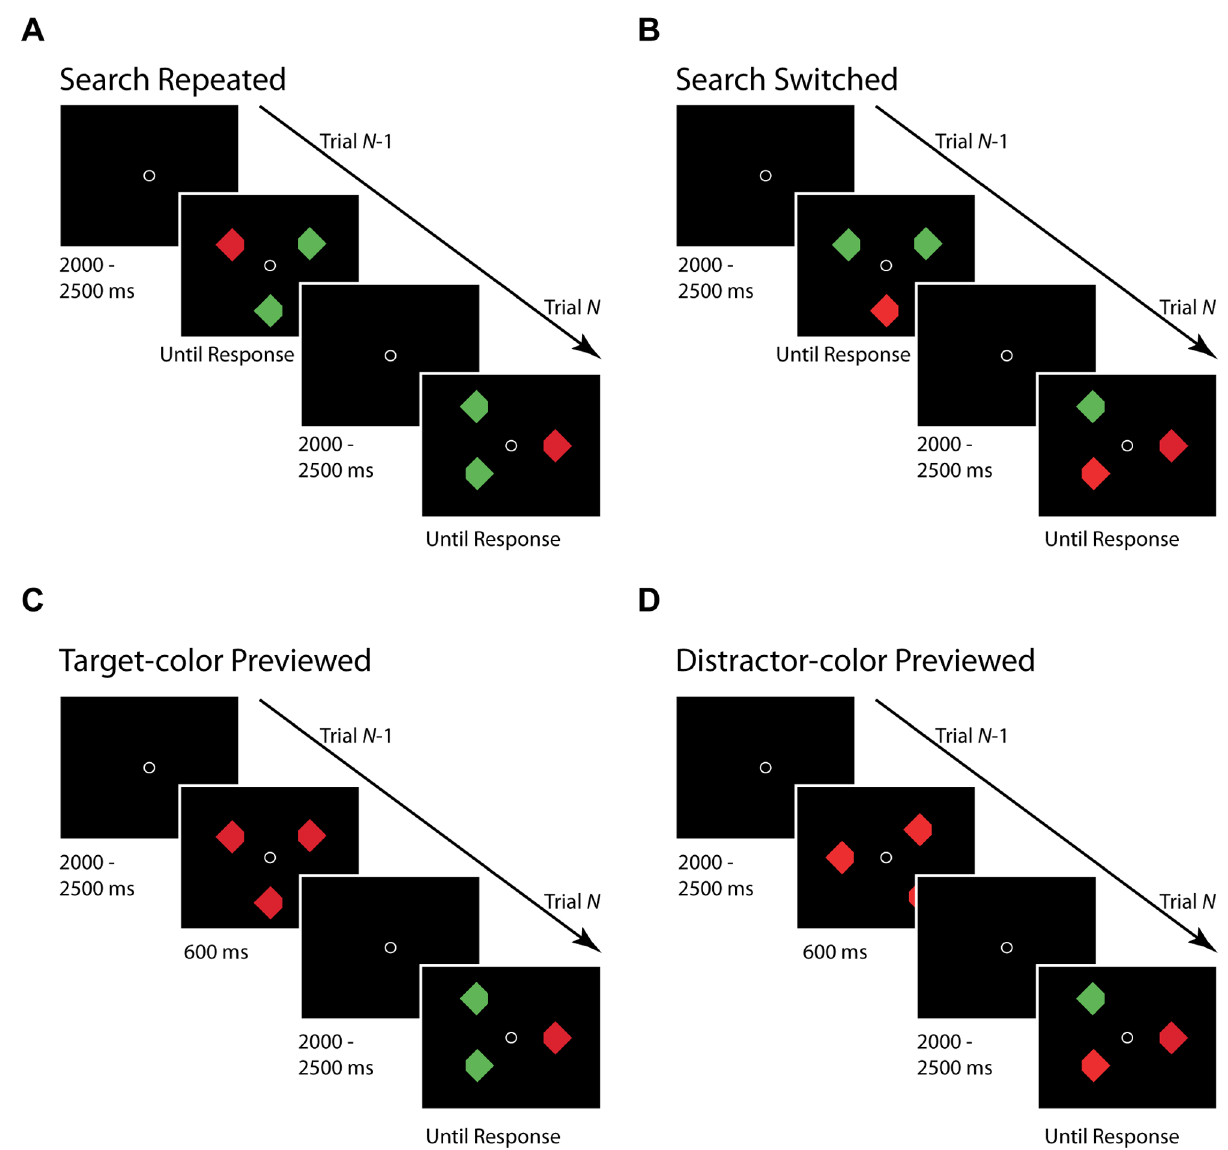
Figure 1. Samples of Four Search Conditions (Target Is Red and Two Distractors Are Green in Current Trial). (a) Search Repeated (target color and distractor color are repeated across consecutive trials); (b) Search Switched (target color and distractor color are switched across consecutive trials); (c) Target-color Previewed (the current target color was the color of objects in the preceding non-target trial); and (d) Distractor- color Previewed (the current distractor color was the color of objects in the preceding non-target trial). Search Repeated and Search Switched conditions comprise the POP search task, and Target-color Previewed and Distractor-color Previewed conditions comprise the DPE search task.